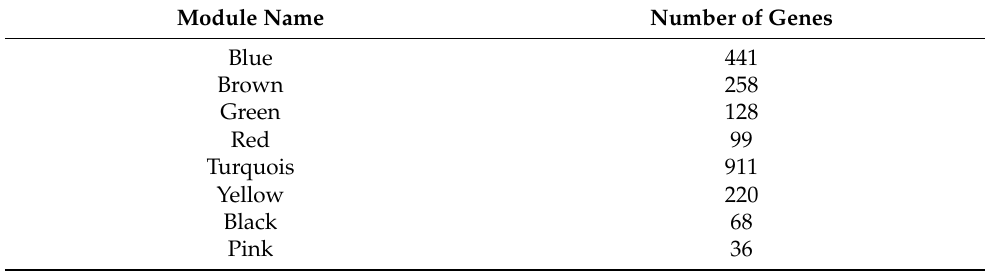
Figure 3. ( a ) Determination of soft-thresholding power ( β ) in the weighted gene co-expression network analysis (WGCNA) and module identification. The left panel shows the analysis of the scale-free fit index for various soft-thresholding powers ( β ). The right panel displays the analysis of the mean connectivity (degree, y-axis) for various soft-thresholding (x-axis) powers. ( b ) Weighted gene co-expression network analysis by the dynamic tree-cutting method. Dendrogram of all DEGs clustered based on a dissimilarity measure (dissTOM). The branches correspond to modules of highly interconnected groups of genes. Each color represents one specific co-expression module, and the tips of the branches represent genes. Table 2. Modules of all treatment studies.